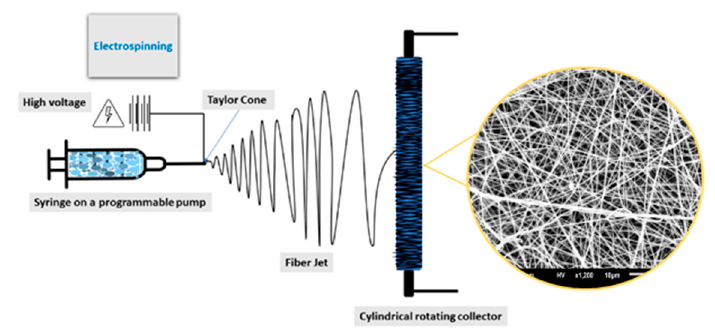
Figure 1. Schematic representation of simple electrospinning set up with rotating cylinder collector.